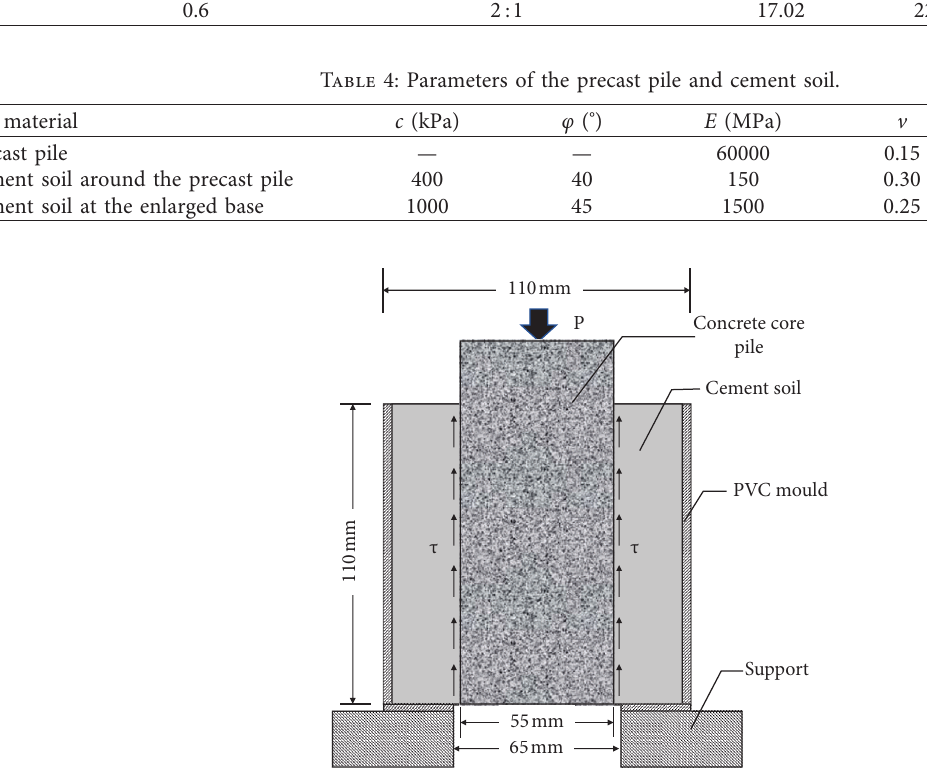
Figure 4: Schematic diagram of concrete-cement soil interface